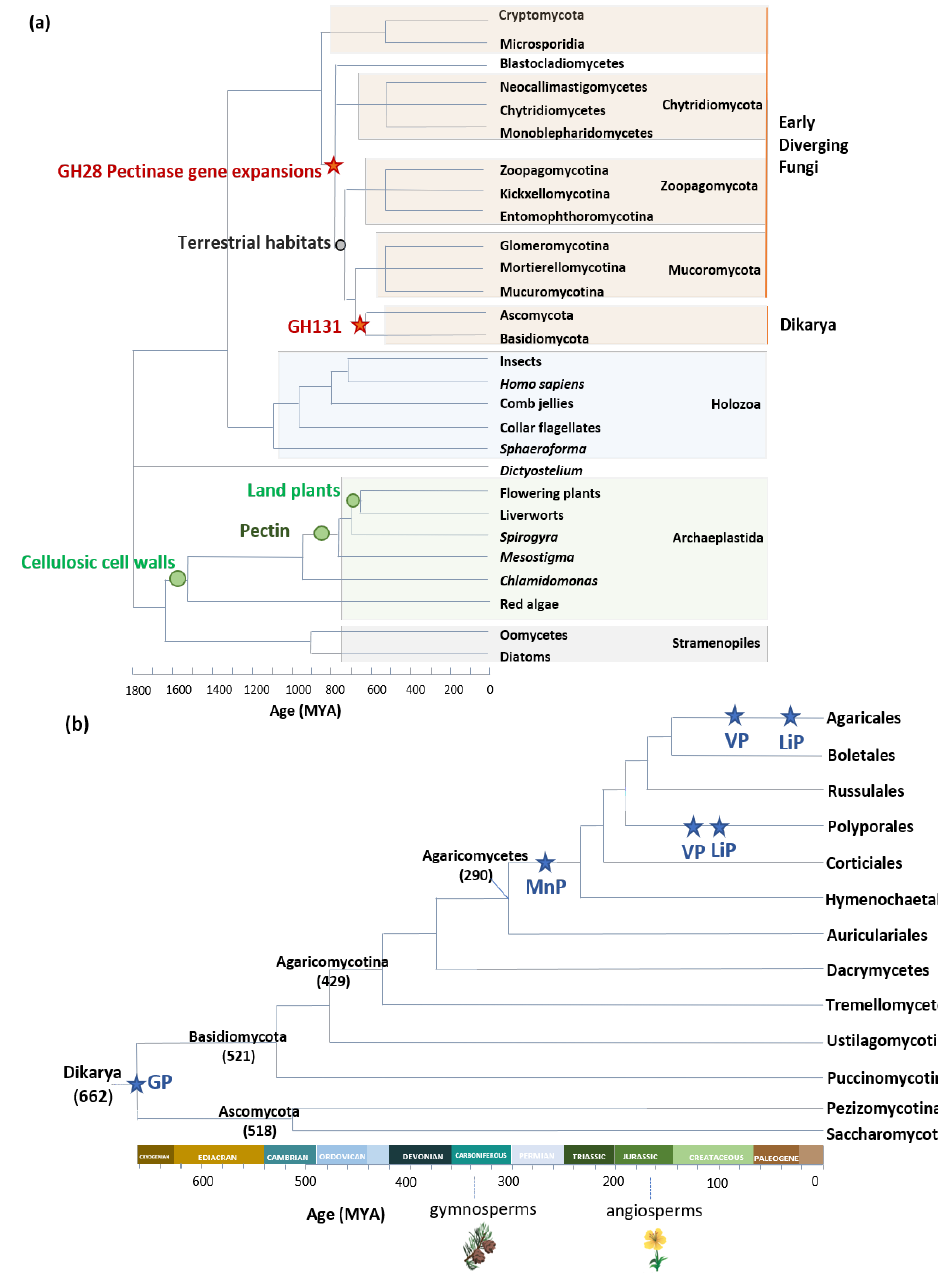
Figure 1. Early evolutionary events for ( a ) GH28 and GH131 enzymes, and ( b ) Class II peroxidases. Estimated ages of fungal taxa from Floudas et al., Chang et al., Berbee et al., Spatafora et al., Ayuso-Fernández et al., and Ruiz-Dueñas et al.